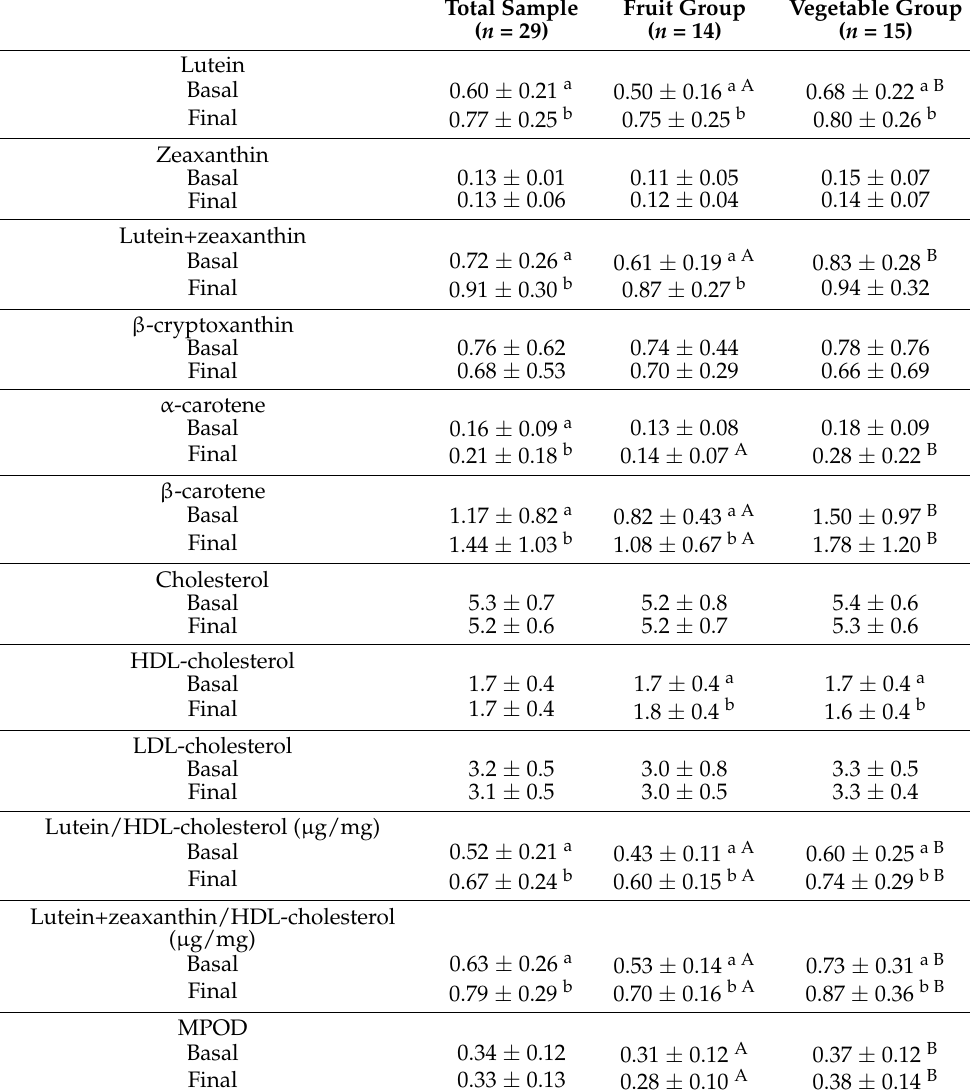
Superscript letters indicate significant differences between basal and final concentrations ( a columns) and between groups ( A rows). D.U.: density units; LDL: low density lipoprotein; HDL: high density lipoprotein; MPOD: macular pigment optical